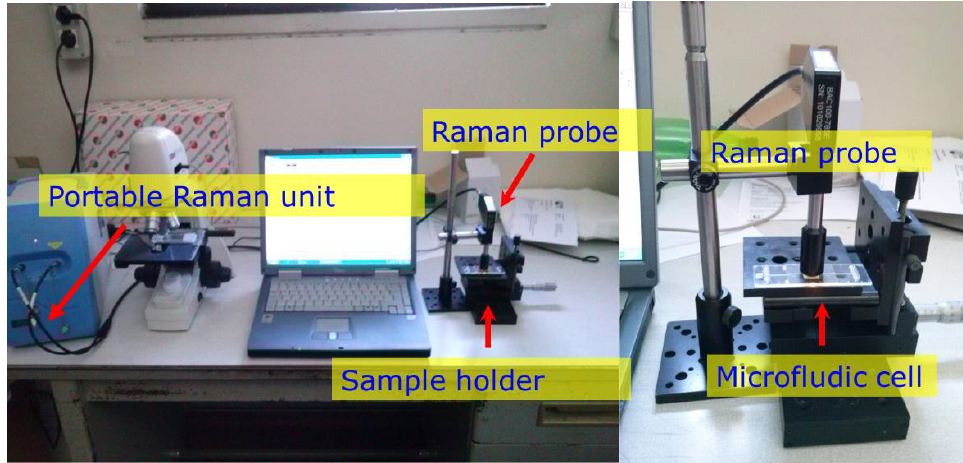
Figure 1. Raman apparatus measuring the surface-enhanced Raman spectroscopy (SERS) sensor in the microfluidic cell (MFC). microfluidic cell